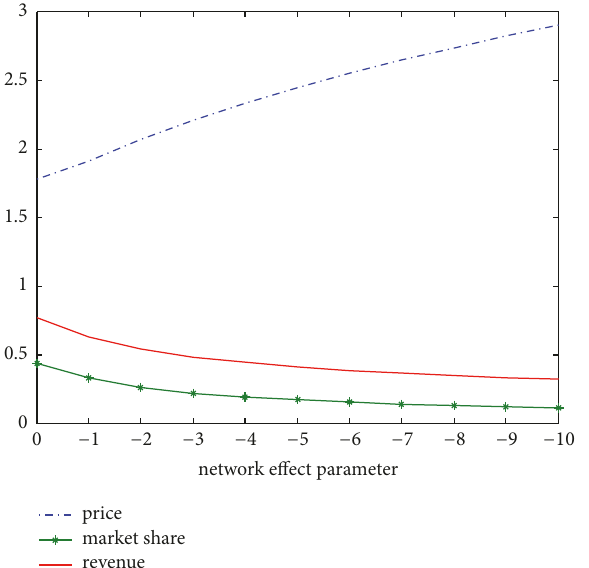
Figure 1: The variation of optimal solutions with network effect parameter.